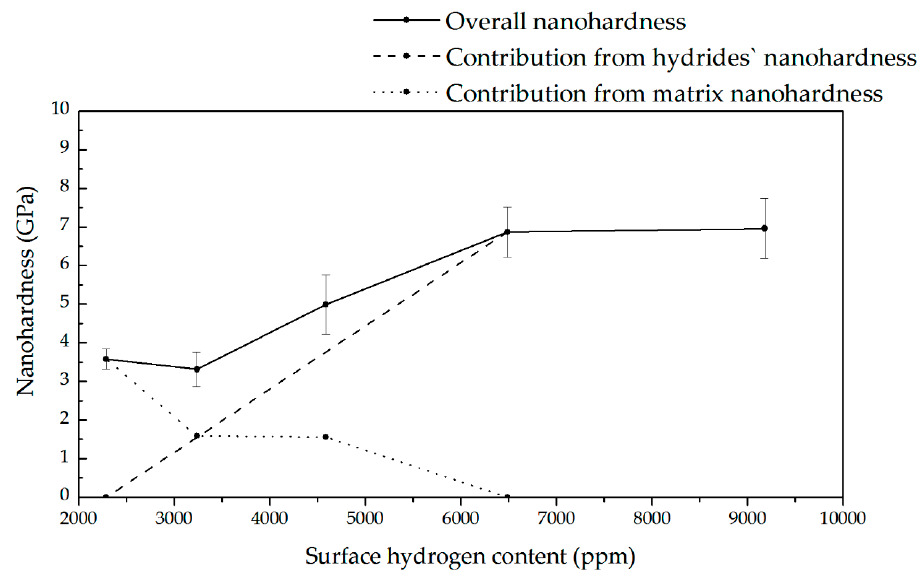
Figure 15. Proposed runs of two components, hydride and hydrogen interstitial solutions, of hardness over surface hydrogen content. The means and standard deviations based on ten independent measurements are shown for the upper curve.